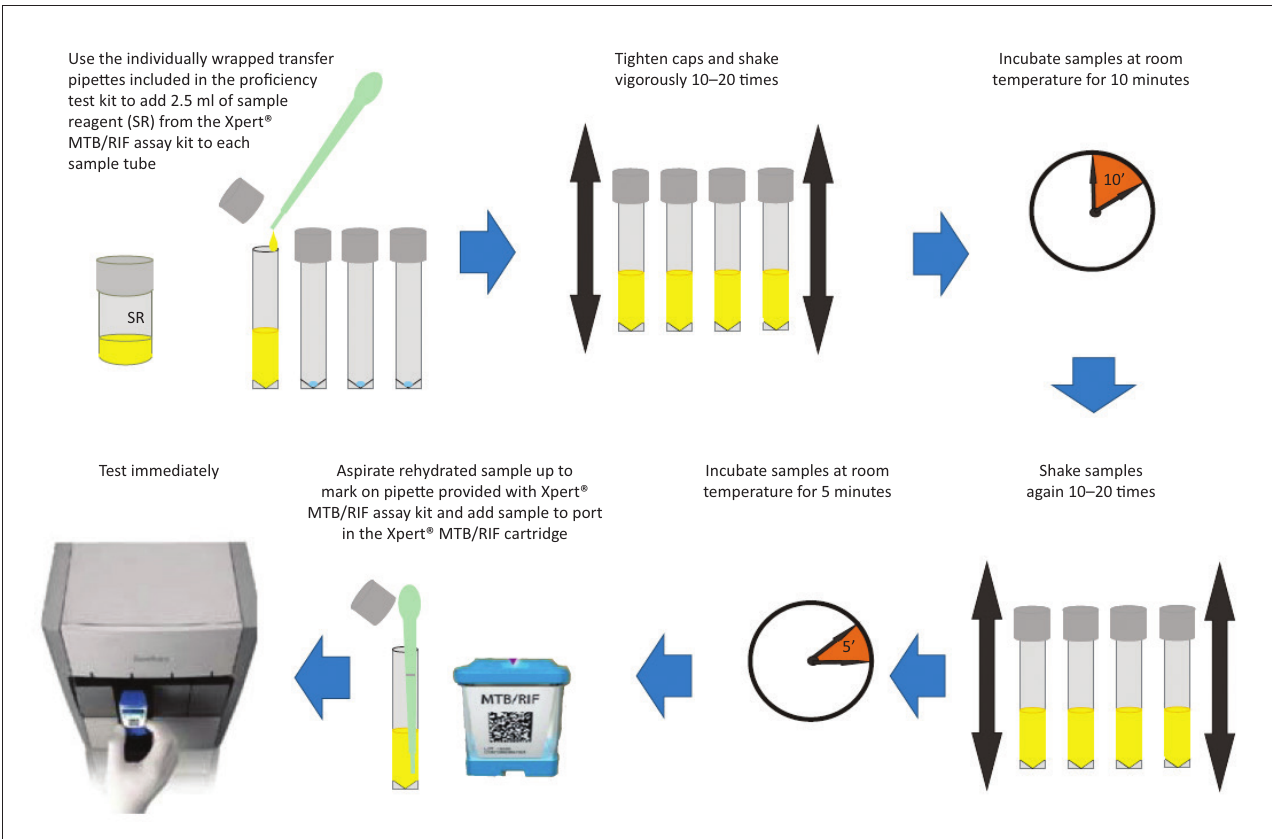
FIGURE 2: Testing dried tube specimens using Xpert MTB/RIF, 2013–2015, United States Centers for Disease Control and Prevention (Atlanta, Georgia, United